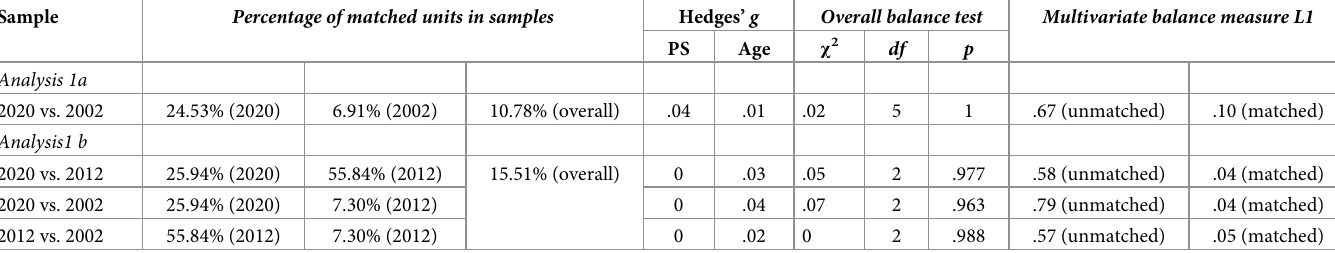
Table 2. Balance tests of the matched samples.